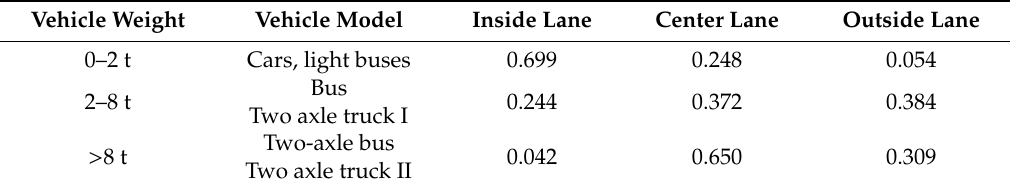
Table 9. Lane distribution coefficient of two-axle vehicles.